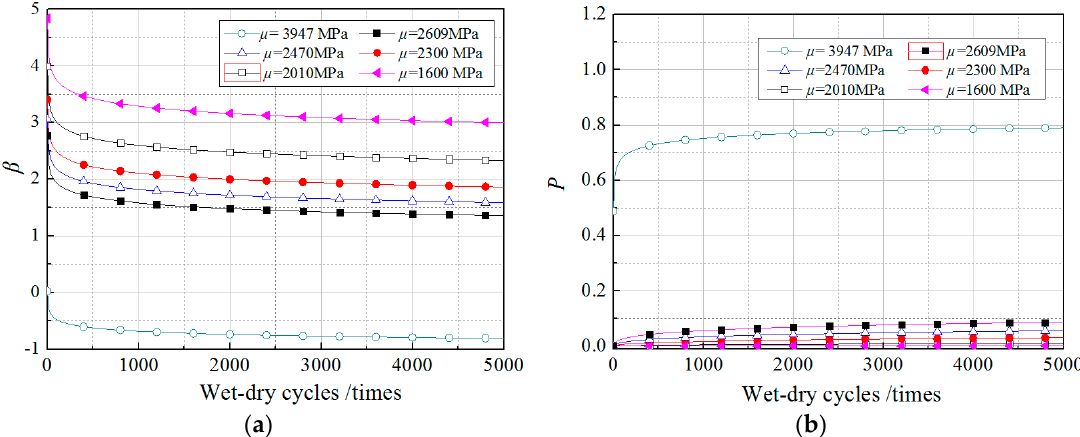
Figure 7. The effects of the mean of the load on the CFRP specimens: ( a ) Change of β with wet-dry cycles; and ( b ) change of P with wet-dry cycles.